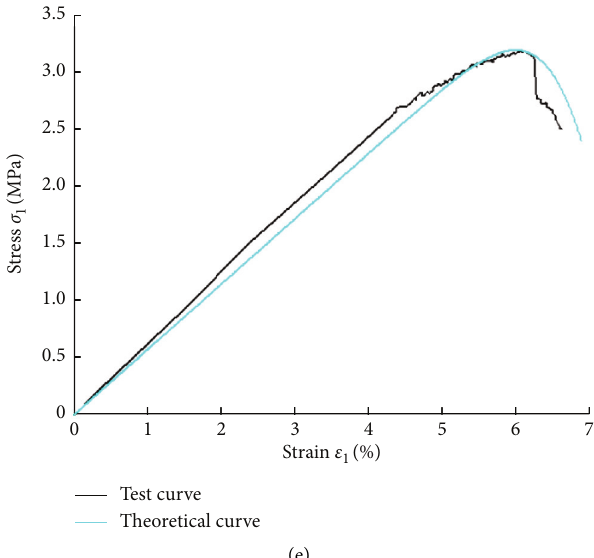
Figure 6: Verification of damage constitutive model for rock under different freeze-thaw cycles. (a) n � 0. (b) n � 5. (c) n � 10. (d) n � 20. (e) n �